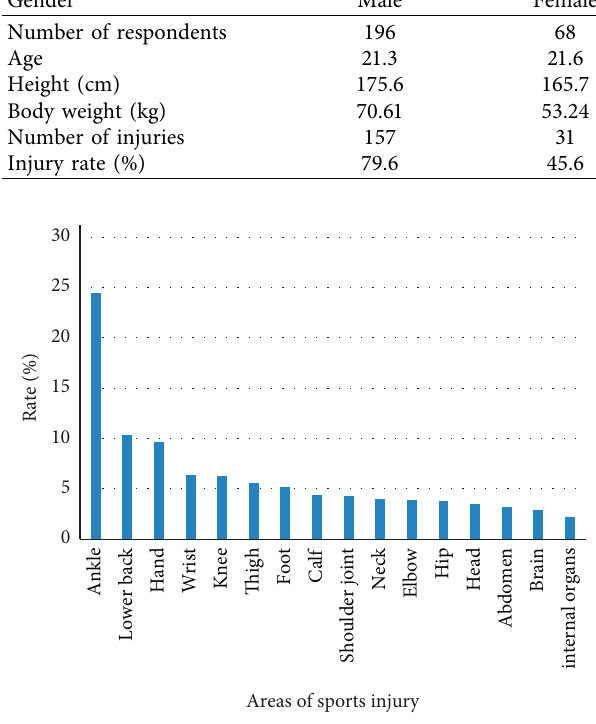
Figure 4: Survey of students’ sports injury